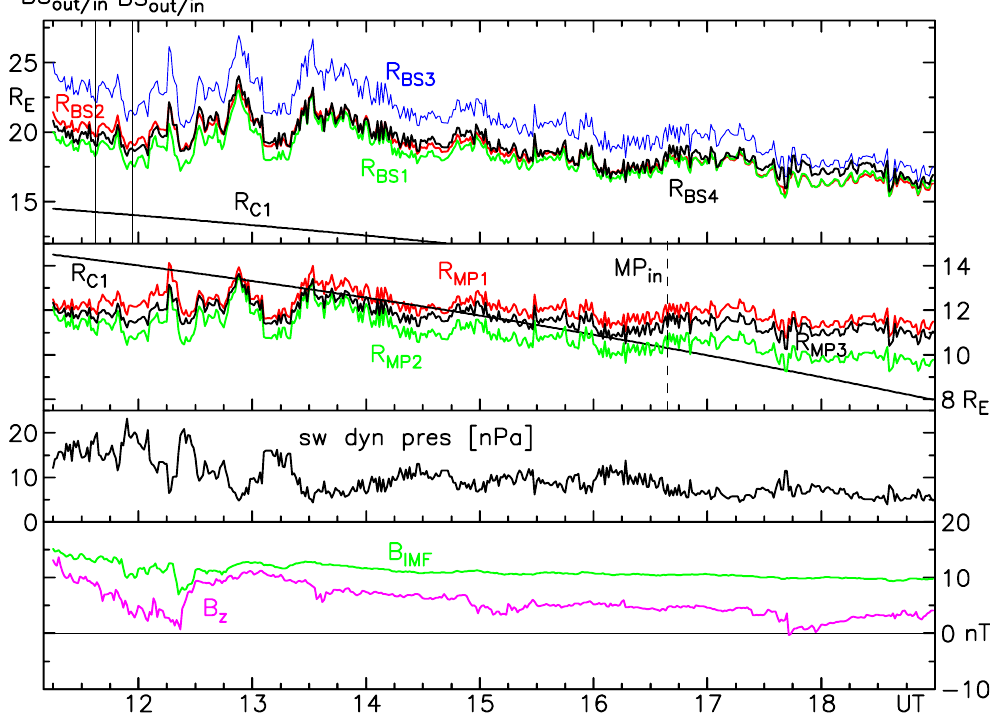
Fig. 8. 31 October 2003. Top panel: model bow shock locations for angular directions of Cluster 1 position: BS1 in green (Farris et al., 1991; Farris and Russell, 1994), BS2 in red (Cairns et al., 1995; Farris and Russell, 1994), BS3 in blue (Jerab et al., 2005), and BS4 in black (Verigin et al., 2001a,b, 2003); spacecraft trajectory R C1 is the black line. Observed bow shock crossings (out- and inbound around 11:37 and 11:57UT) are marked by vertical lines. Panel 2: model magnetopause locations for Cluster 1 angular directions: MP1 in red (Shue et al., 1998), MP2 in green (Lin et al., 2010), and MP3 in black (new model); spacecraft trajectory R C1 is the black line; dashed line is magnetopause crossing. Panel 3: solar wind dynamic pressure. Bottom panel: IMF total value (green) and B z (lilac). Interplanetary data from ACE